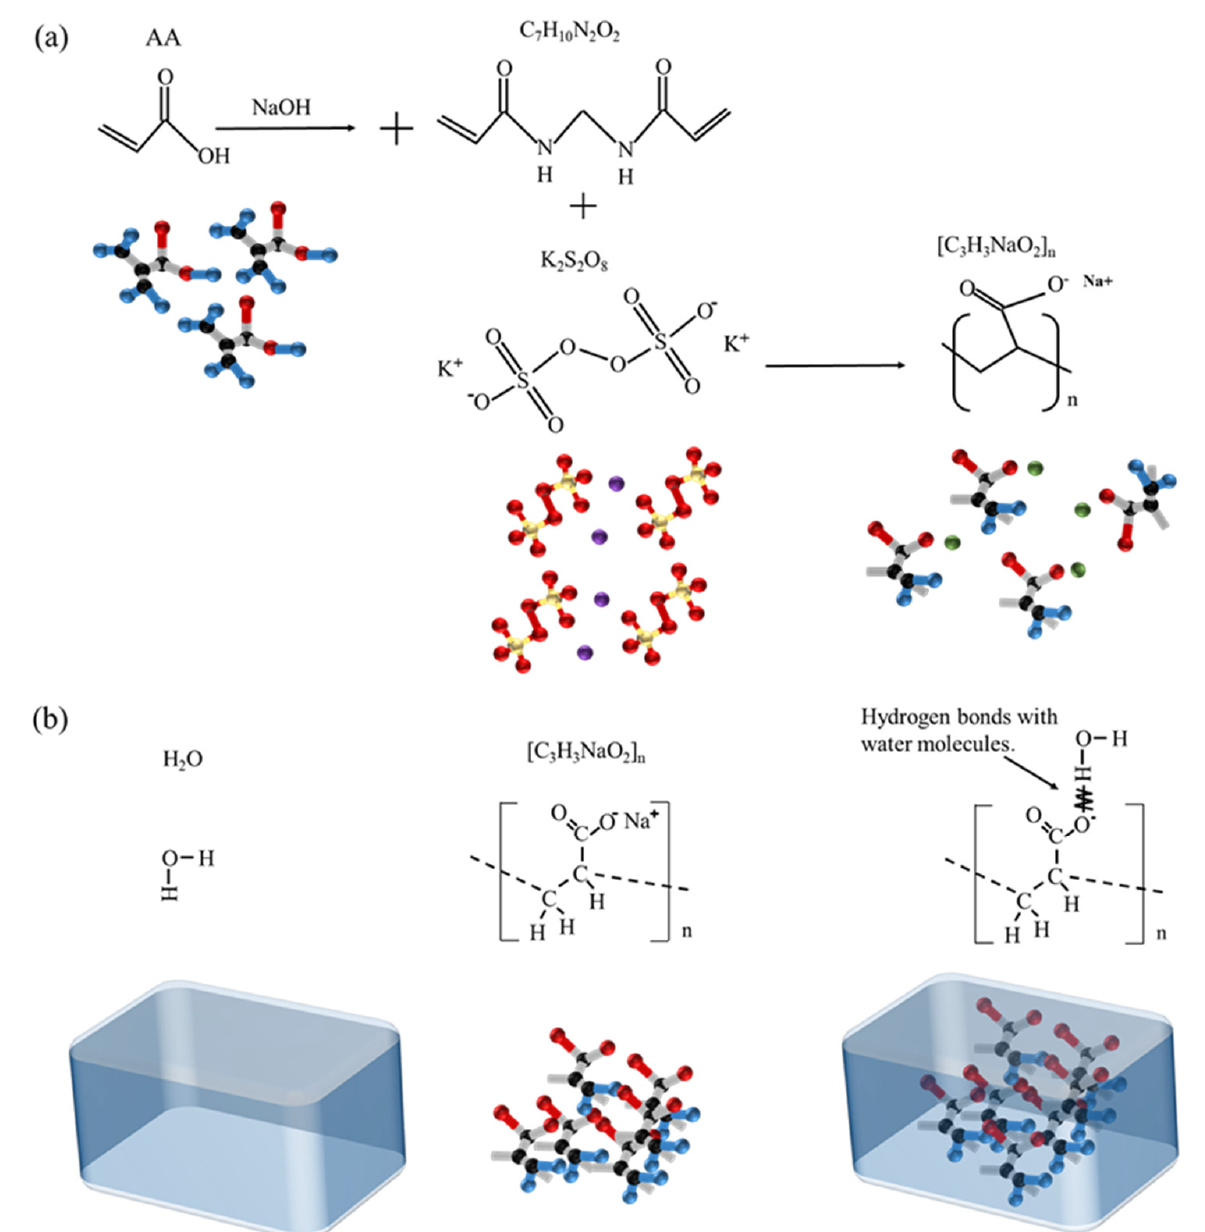
Figure 1. Spatial structure of materials. ( a ) Synthesis of sodium polyacrylate. ( b ) Formation principle of hydrogel [33].